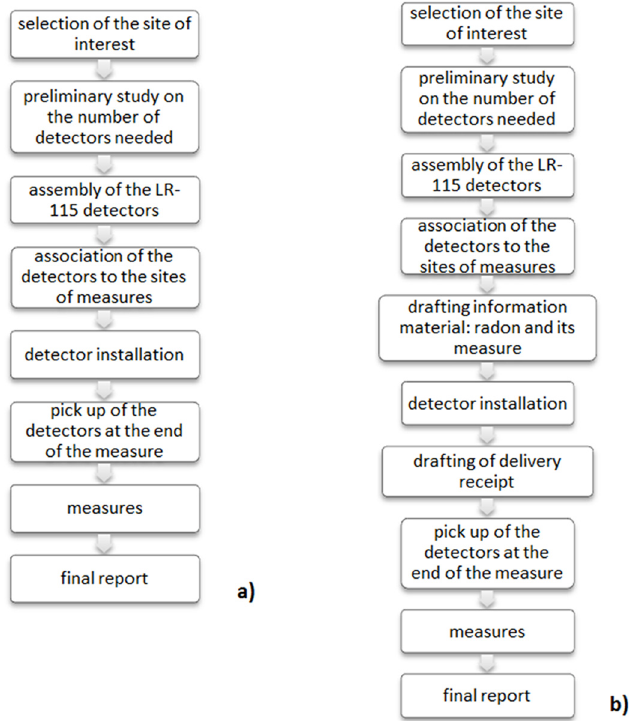
Fig. 3. (a) Standard fl owchart of LaRa; (b) new fl owchart for measurement ’ s campaign in Puglia.